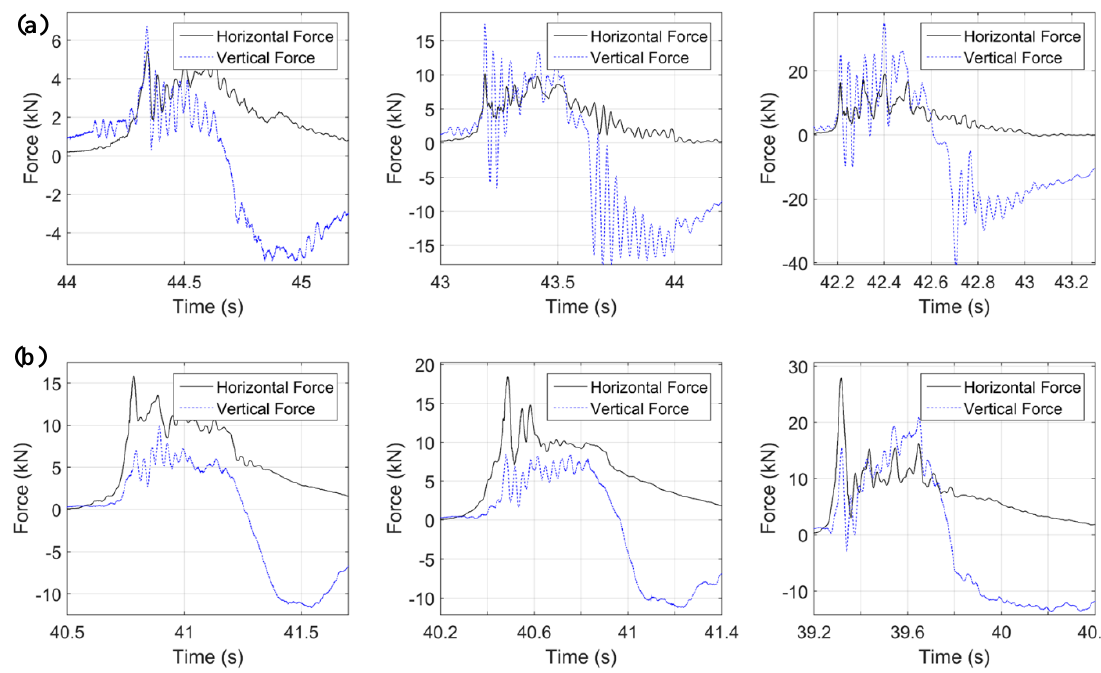
Figure 6. Total horizontal and vertical forces for ( a ) solitary waves (top) with H = 0.42 m (left), H = 0.55 m (center) and H = 0.70 m (right), and ( b ) bores (bottom) with H = 1.0 m (left), H = 1.10 m (center) and H = 1.40 m (right).